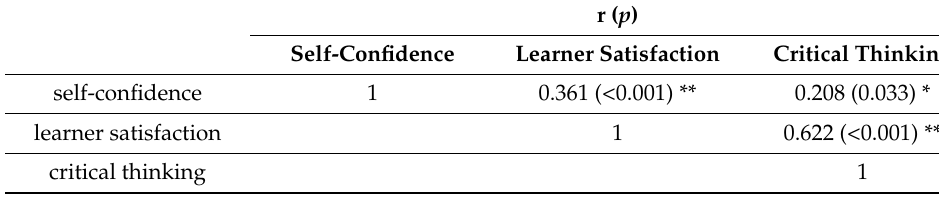
Table 3. Correlation between variables.